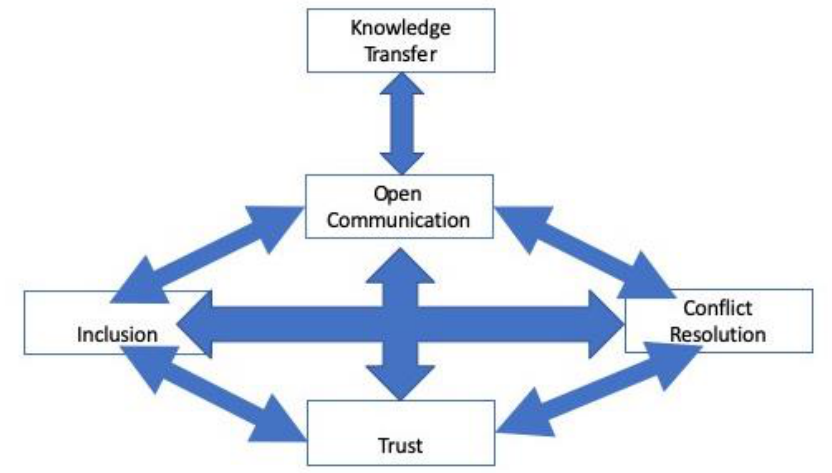
Fig. 1 . Interrelatedness of multigenerational skills (Cox & Holloway,